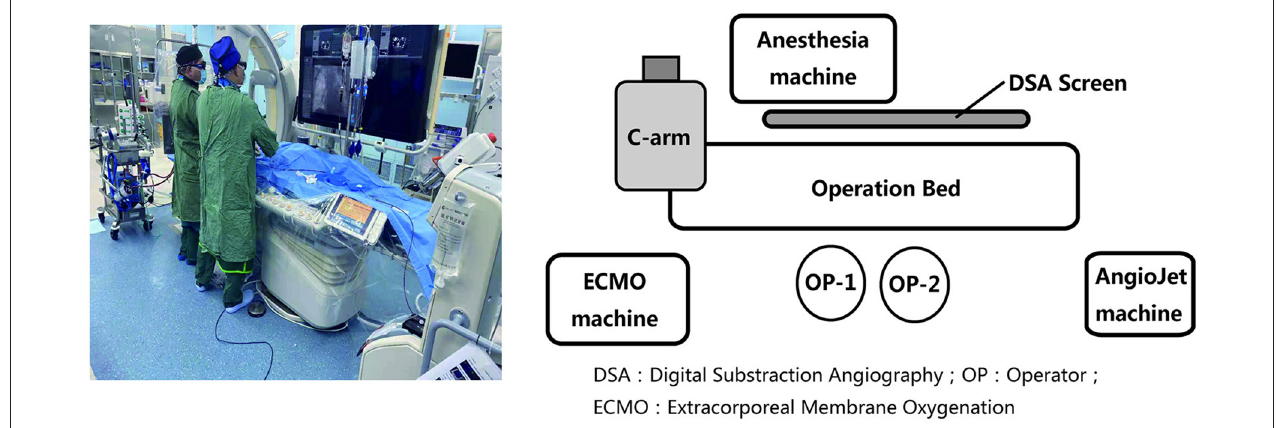
FIGURE 2 | Percutaneous mechanical thrombectomy procedure with patients receiving general anesthesia continued VA-ECMO circulation in the hybrid operating room. DSA, Digital Substraction Angiography; OP, Operator; ECMO, Extracorporeal Membrane Oxygenation.